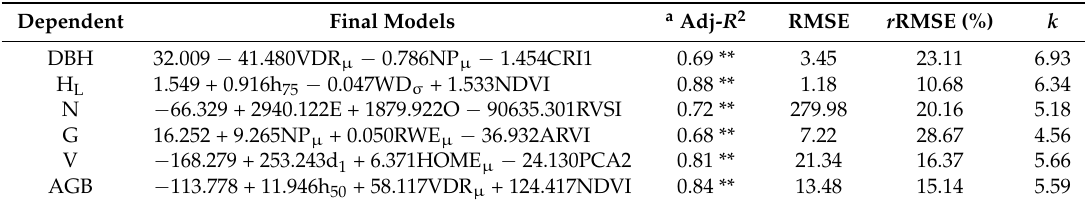
Table 7. Summary of the forest structural parameters prediction models with integrated point cloud, full-waveform and hyperspectral metrics and plot-level accuracy assessment